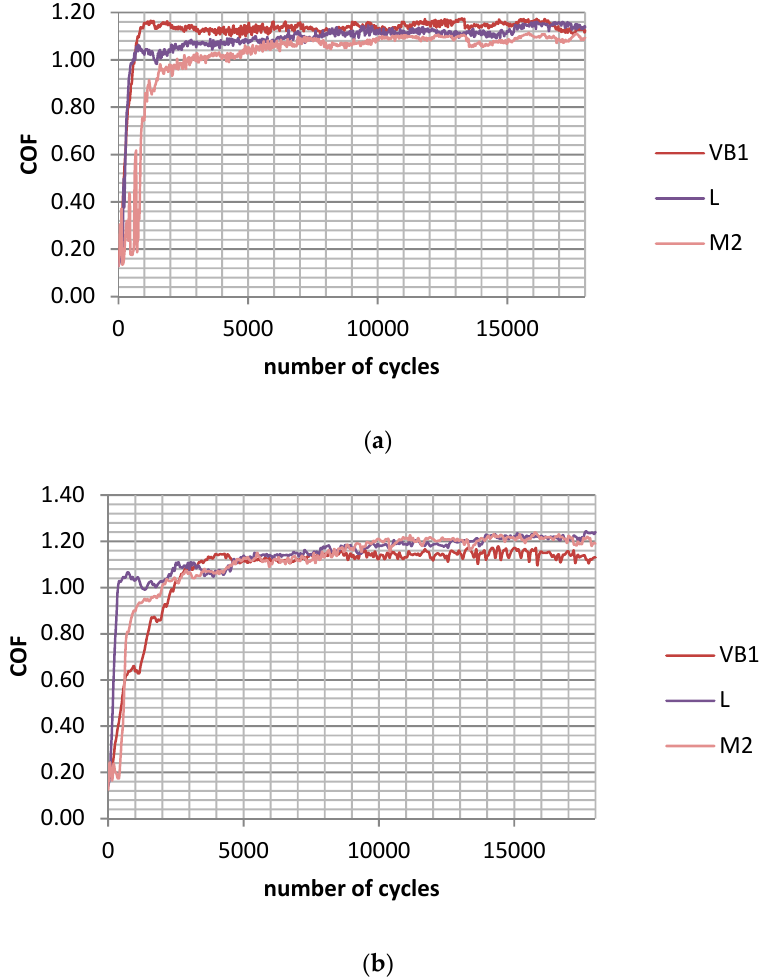
Figure 6. Maximum coefficient of friction during test D; s = 0.1 mm, P = 15 N, f = 20 Hz; ( a ) and during test E; s = 0.1 mm, P = 15 N, f = 50 Hz ( b ) for selected assemblies with discs: after vapour blasting VB1, after lapping L and after milling M2.